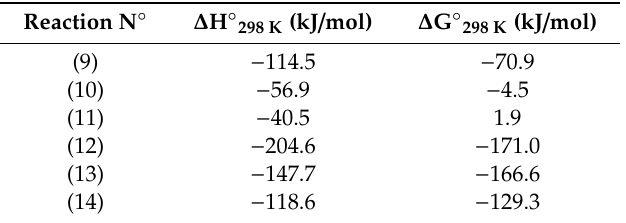
Table 2. Thermodynamic data for gas and liquid phase reactions (reactions taken Suchak et al. [15] and values corrected using HSC V.9.0).